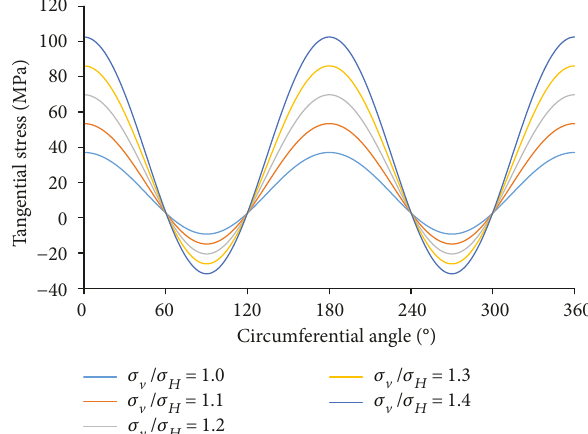
Figure 6: The relationship curves between tangential stress and circumferential angle of di ff erent σ v / σ H